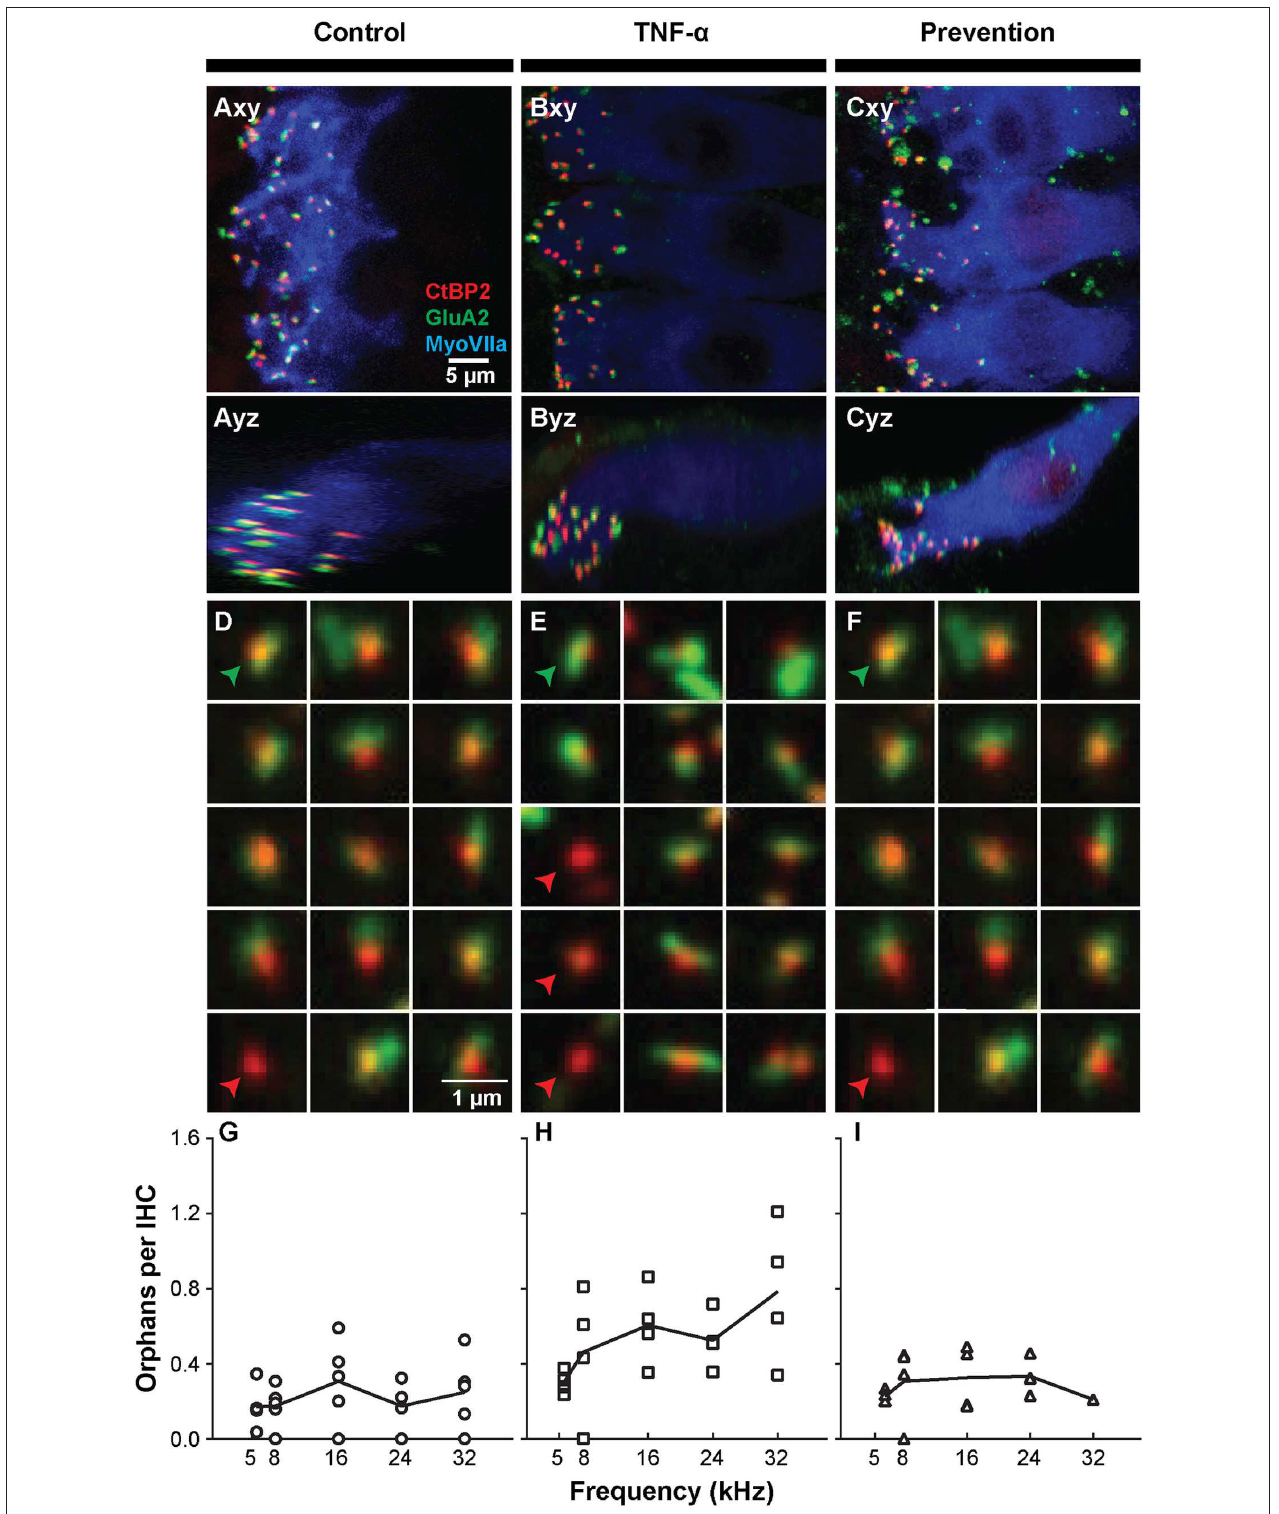
FIGURE 4 | Intracochlear TNF- α perfusion increases the number of orphaned synapses at the basal pole of inner hair cells. Left column shows results from the control group (perfused with artificial perilymph); middle column shows results from the TNF- α group; right column shows results from the prevention group (animals